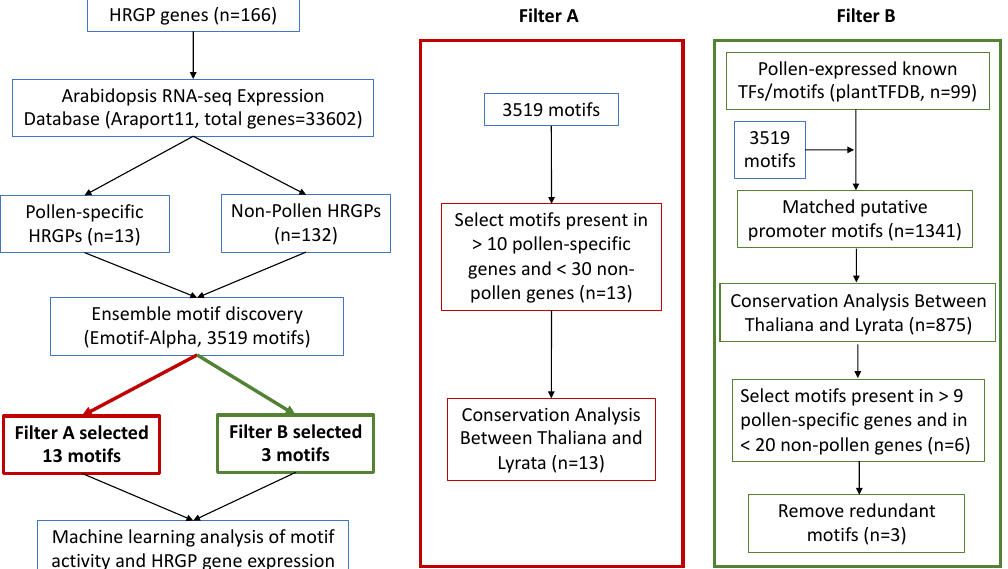
Figure 1. Workflow of an integrative analysis combining hydroxyproline-rich glycoproteins (HRGP) gene expression and promoter sequences. HRGP genes were split into pollen-specific and non-pollen (i.e., not expressed in pollen) based on tissue-specific gene expression analysis from Araport11 [5]. Ensemble motif discovery was performed on the aforementioned two sets and a total of 3519 motifs were identified, which were used by the two filters. Filter A is a more relaxed approach where the motifs are filtered based on the number of occurrences ( > 10 in pollen-specific HRGPs and < 30 in non-pollen HRGPs) and conservation criterion. Filter B is a more rigorous approach, involving 99 motifs whose cognate transcription factors are expressed in pollen based on data obtained from plantTFDB [8]. Known motif similarity found that 1341 de novo motifs out of the total 3519 motifs were highly similar to the 99 motifs ( p -value < 0.001). The set was then filtered by conservation and number of occurrences, with redundant motifs being removed. In total, filter A and filter B identified 15 motifs (with one motif being identified by both filter A and filter B) putatively controlling pollen-specific HRGP gene expression; these motifs were then fit into a regression model that integrated the promoter elements and HRGP gene